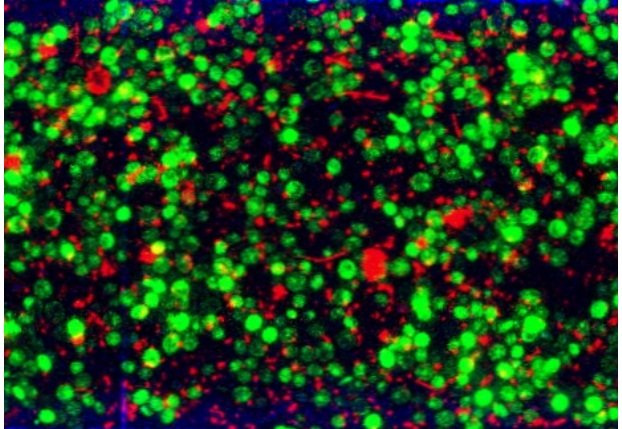
Figure 14. Composite image of a 0.8 µm pore size microsieve fouled with one layer of E. coli and S. cerevisiae